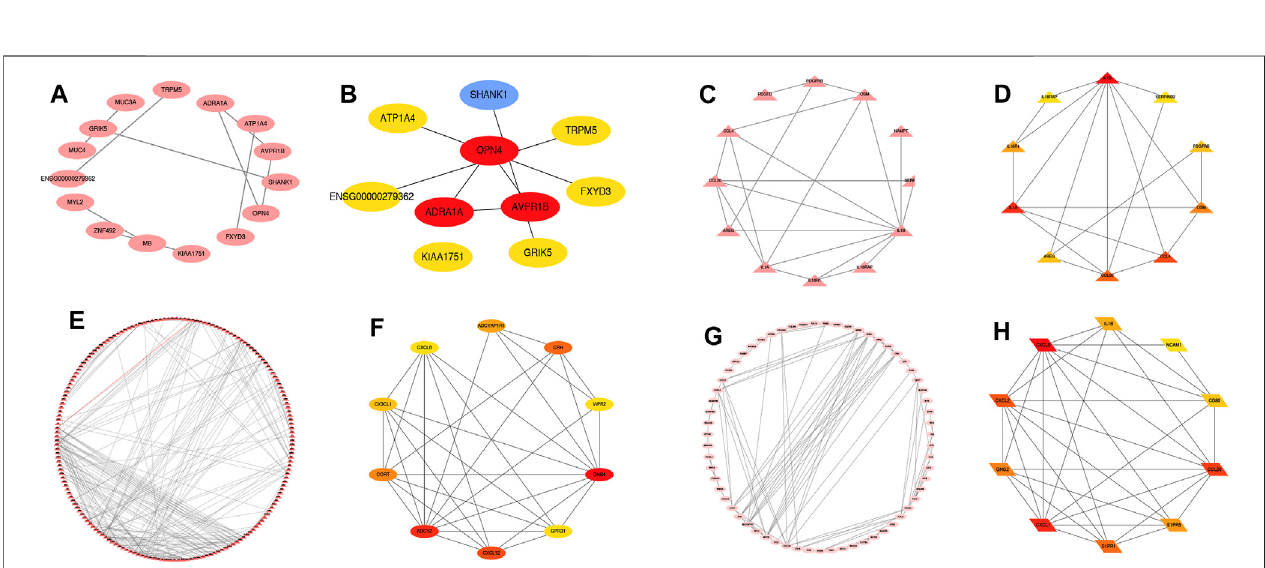
FIGURE 4 | Gene set enrichment analysis (GSEA) enrichment analysis based on integrated expression matrix and grouping. Based on the integrated expression matrix, the samples were divided into cardiomyopathy and normal groups, and then the GSEA enrichment analysis was performed after grouping; the pathways that werepositivelyassociatedwithcardiomyopathyaremainlyenriched( Figure4A );thepathwaysthatwerenegativelyassociatedwithcardiomyopathyaremainlyenriched ( Figure 4B ).